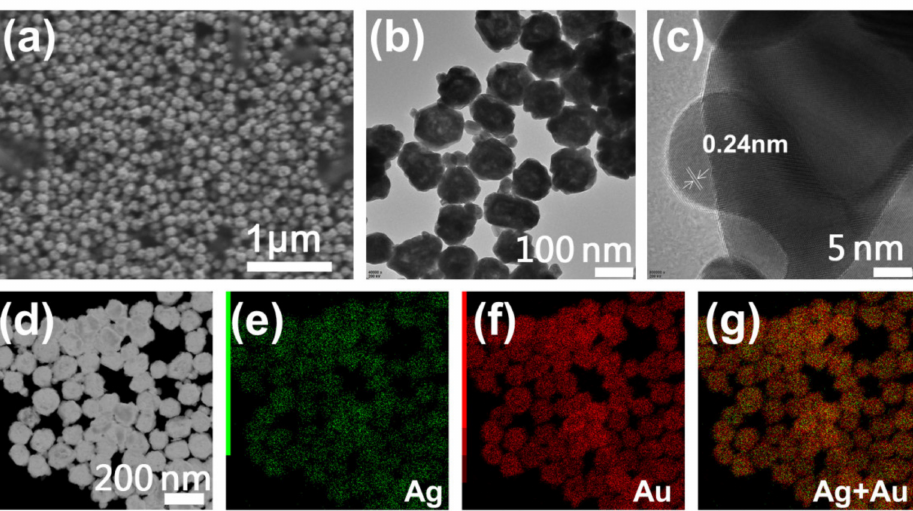
Figure 2. ( a ) SEM, ( b ) TEM, ( c ) HRTEM, and ( d ) HAADF images of as-prepared Ag@Au nanoparticles, when the amount of Ag seed was 500 µ L. ( e – g ) The corresponding EDS